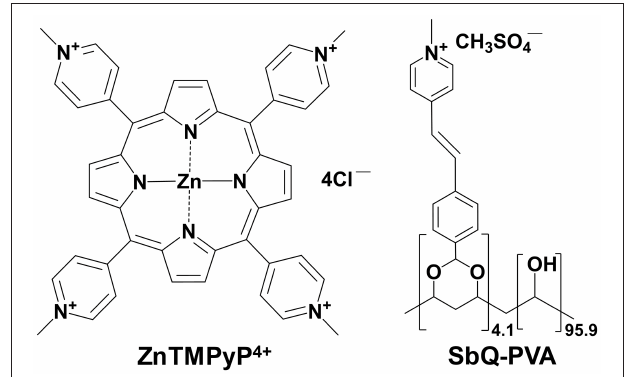
FIGURE 1 | Chemical structures of (left) the ZnTMPyP 4 + photosensitizer and (right) the water-soluble, photocrosslinkable SbQ-PVA polymer.